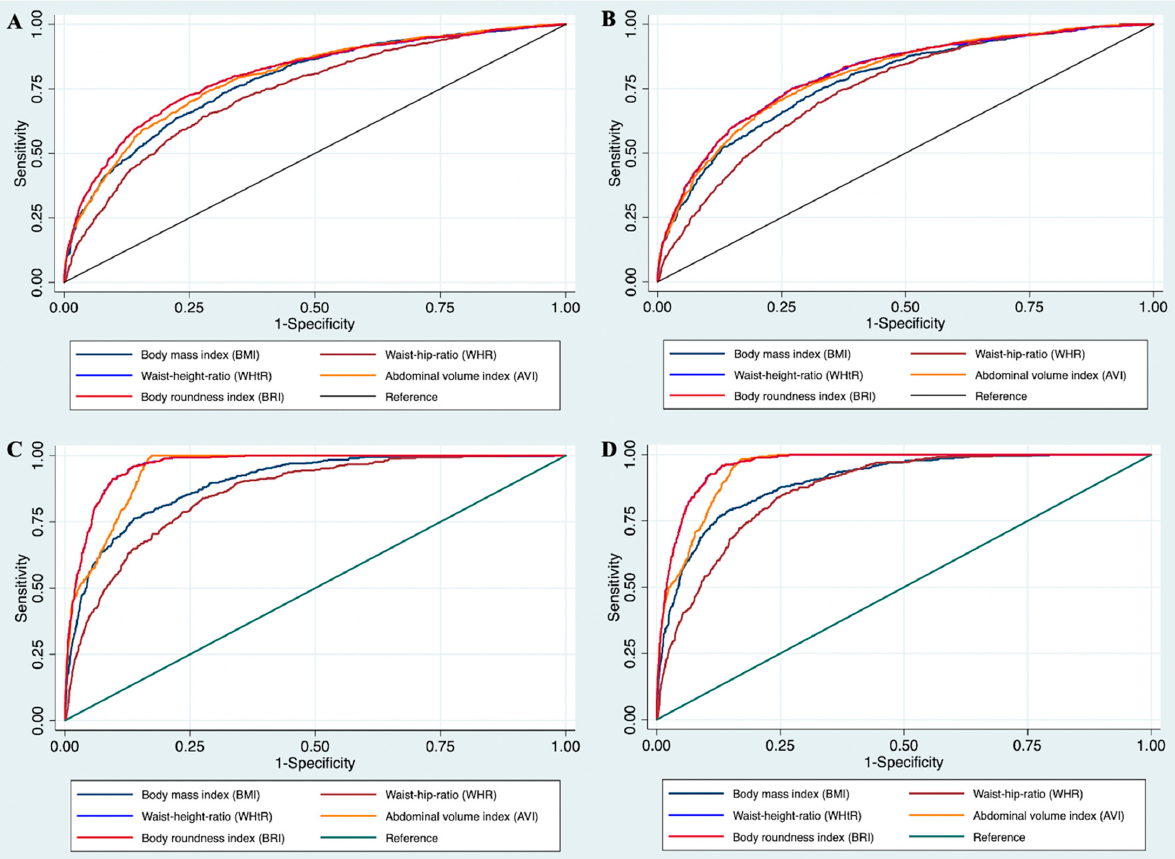
Figure 1. The receiver operating characteristic (ROC) curves for Body mass index (BMI), Waist–hip ratio (WHR), Waist–height ratio (WHtR), Abdominal volume index (AVI), and Body roundness index (BRI) values to detect metabolic syndrome by 1. National Cholesterol Education Program, Adult Treatment Panel III (NCEP ATP III) in males ( A ) and females ( B ); 2. International Diabetes Federation (IDF) in males ( C ) and females ( D ). p -values in four models <0.01 which reflect the differences in area under the ROC curve are statistically